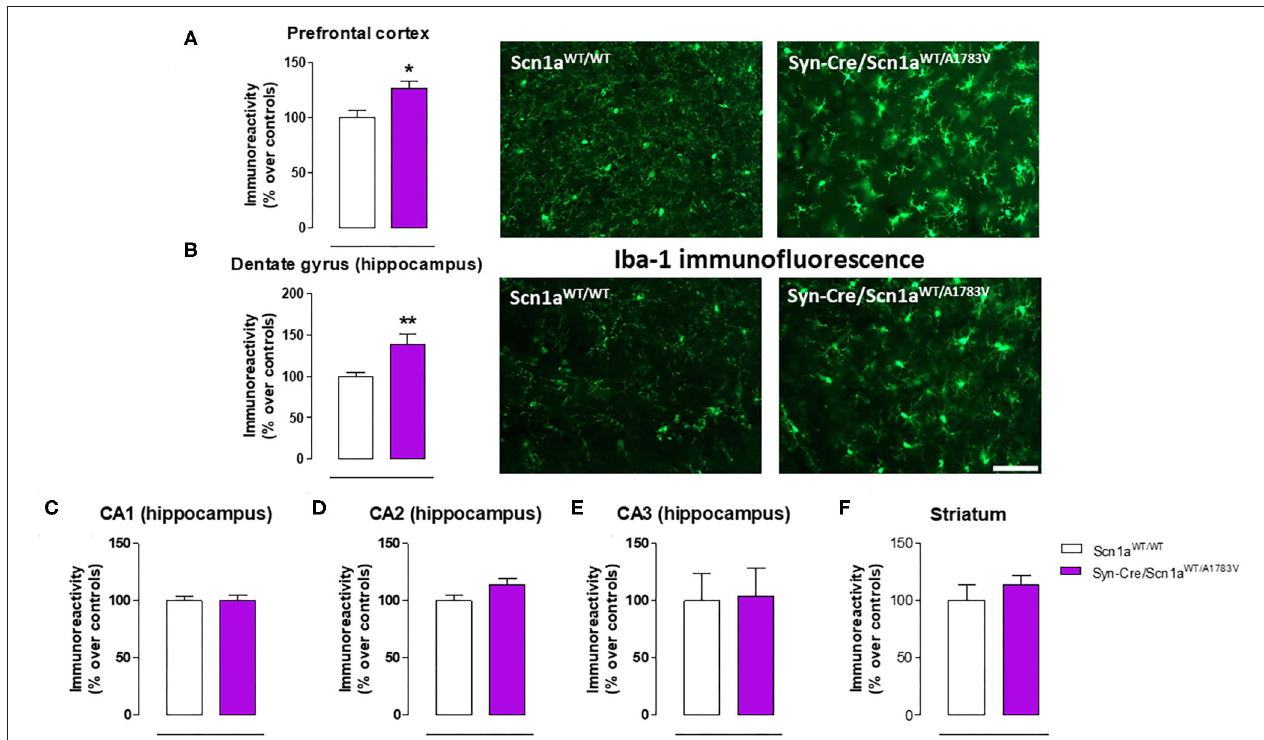
FIGURE 7 | Immunoreactivity for the microglial marker Iba-1 measured by immunofluorescence in different CNS structures, including representative immunofluorescence images in the prefrontal cortex and the hippocampal dentate gyrus, of Syn-Cre/Scn1a WT / A1783V mice compared with Scn1a WT / W animals at PND25. Values are % over controls and correspond to means ± SEM of five to six animals per group. Data were assessed by the Student’s t -test (* p < 0.05, ** p < 0.01 vs. the control group). Scale bar = 100 µ m.